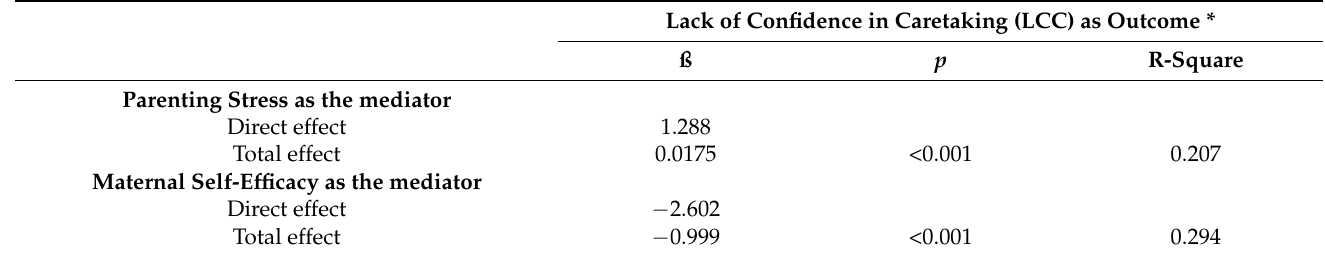
Table 3. Defined parameters. Lack of Confidence in Caretaking (LCC) as Outcome *